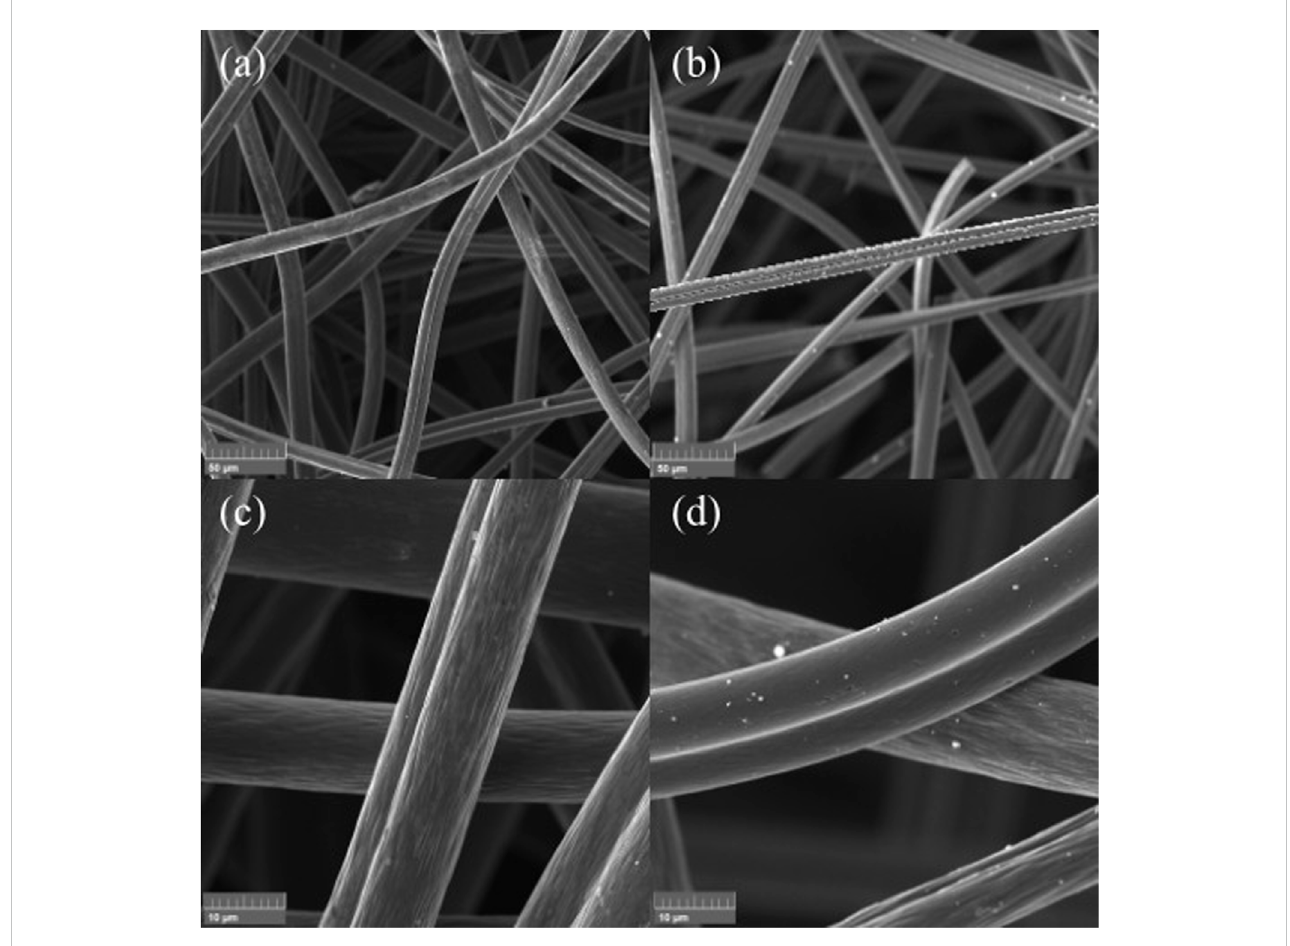
ACFandAg@ACFFEG-SEMmicrographs: (A) ACFat1kxmagni fi cation; (B) Ag@ACFat1kxmagni fi cation; (C) ACFat5kxmagni fi cation; (D) Ag@ACFat5kx magni fi